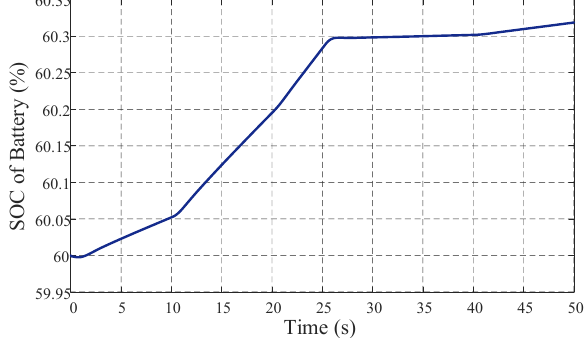
Figure 24. Battery SOC.